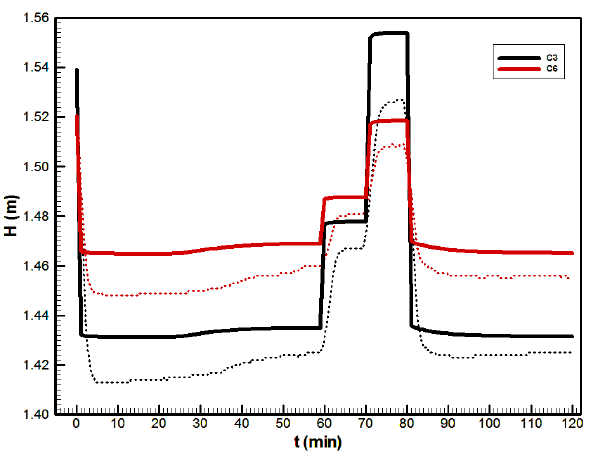
Figure 11. Hydraulic head: Experimental (dashed line) and numerical (solid line) results for the two most dynamic piezometers that were closest to the